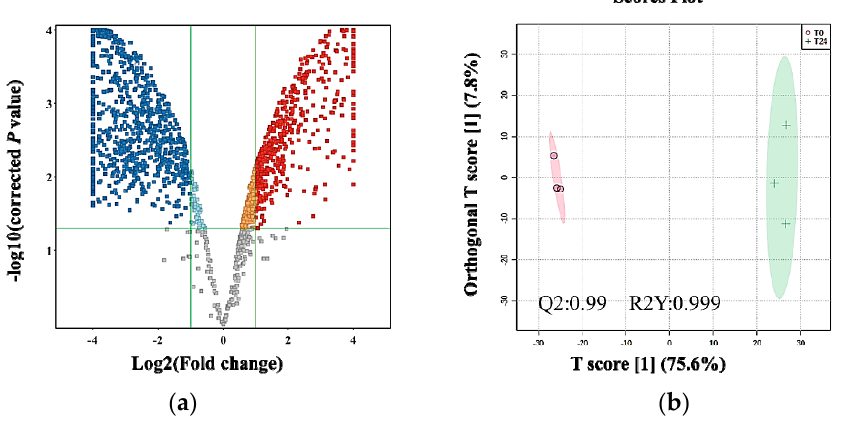
Figure 5. Dysregulated metabolites in MDA-MB-231 cells after 24 h of treatment with E. coli secretome. The culture-background-free features ( n = 1760) were filtered using ( a ) a volcano plot, showing that 478 metabolites were upregulated (red) and 847 metabolites were downregulated (blue) after 24 h of treatment compared to the control, respectively (cutoff: FDR p -value ≤ 0.05 and FC 2). ( b ) An OPLS-DA model of the treatment shows a clear separation between 0 and 24 h